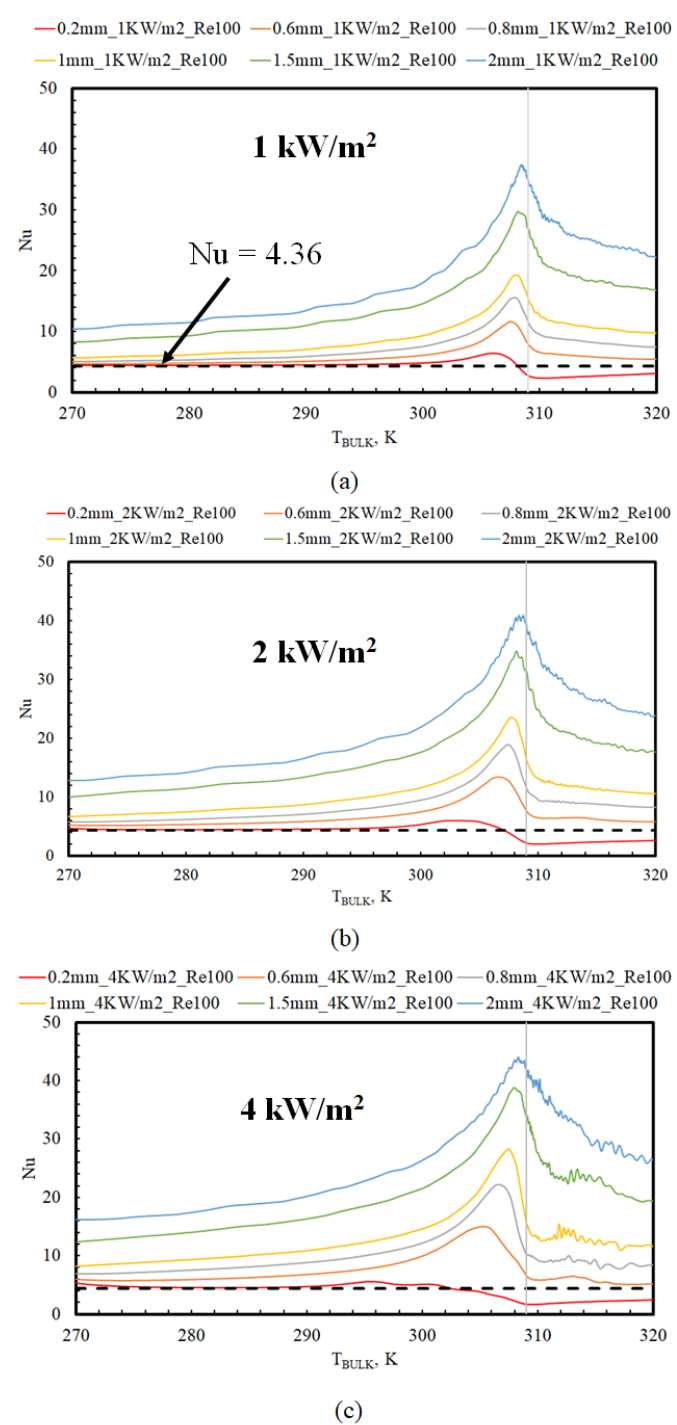
Figure 2. Nu versus bulk temperature (T BULK ) (Re 100) at different tube diameters for wall heat fluxes of: ( a ) 1 kW/m 2 ; ( b ) 2 kW/m 2 ; ( c ) 4 kW/m 2 .